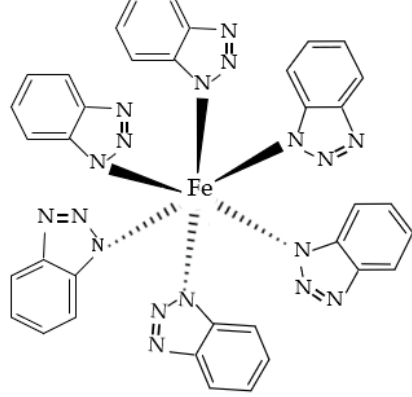
Figure 7. Chemical structure of C 36 H 24 FeN 18 .